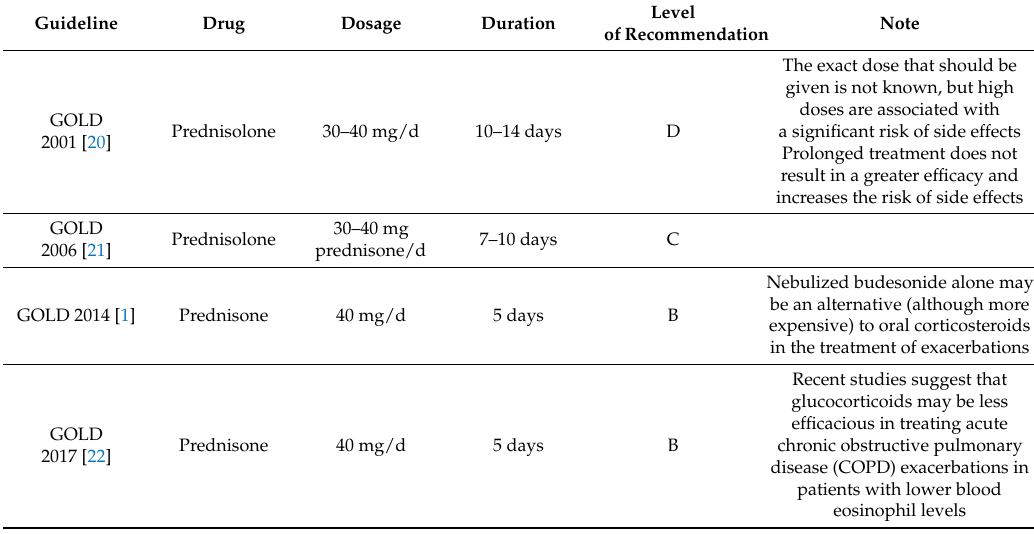
Table 2. Global Initiative for Chronic Obstructive Lung Disease (GOLD) recommendations regarding the treatment of acute exacerbations of COPD with